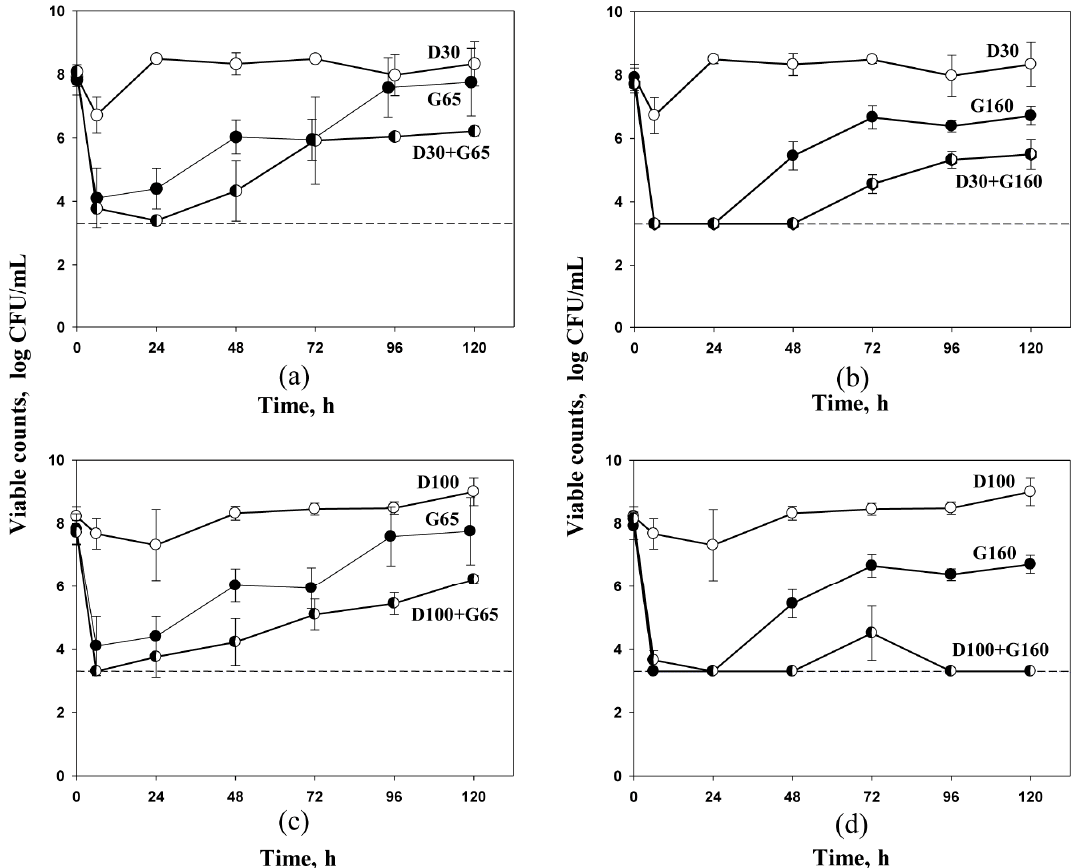
Figure 1. Time–kill curves of daptomycin and gentamicin, alone and in combination against S. aureus 293. Dosing regimens are indicated at each curve. Dotted lines indicate the limit of detection. Data are presented as arithmetic means ± standard deviations. ( a )—regimens D30, G65 and D30+G65; ( b )— regimens D30, G160 and D30+G160; ( c )—regimens D100, G65 and D100+G65; ( d )—regimens D100, G 160 and D100+G160.